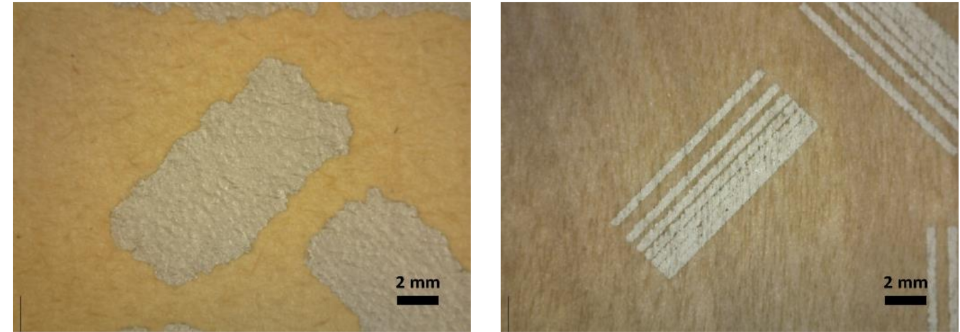
Figure 3. Minimum-gap-width test structure printed on CB_ref ( left ) and Veneer_ref ( right )